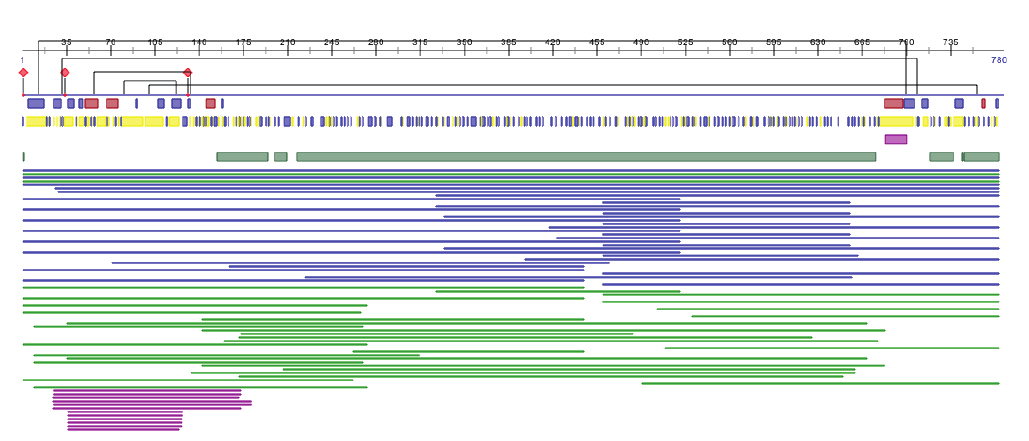
Figure 5. FeatureViewer is used by the PredictProtein service to show a stack of predicted structure and function features.